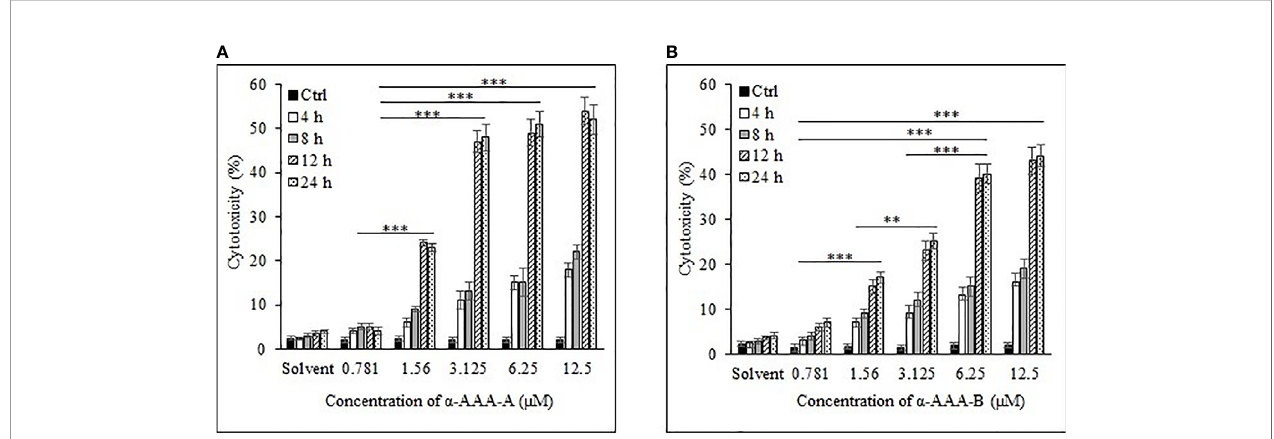
FIGURE 2 | Cancer cell line HL-60 cytotoxicity by a -AAA-A (A) and a -AAA-B (B) at different concentrations and durations of incubations. *** P <0.001, when comparing cytotoxicity by a -AAA-A at 12.5, 6.25 and 3.125 m M with 1.56 m M after 12 and 24 h of incubations. *** P <0.001, on comparing cytotoxicity by a -AAA-B at 12.5, 6.25 and 3.125 m M with 1.56 m M after 12 and 24 h of incubations. ** P <0.01, on comparing cytotoxicity by a -AAA-B at 1.56 with 3.125 m M. *** P <0.001, on comparing cytotoxicity by a -AAA-A and a -AAA-B at 0.781 and 1.56 m M. Cancer cells without molecules served as control. Solvent was also used for different conditions.